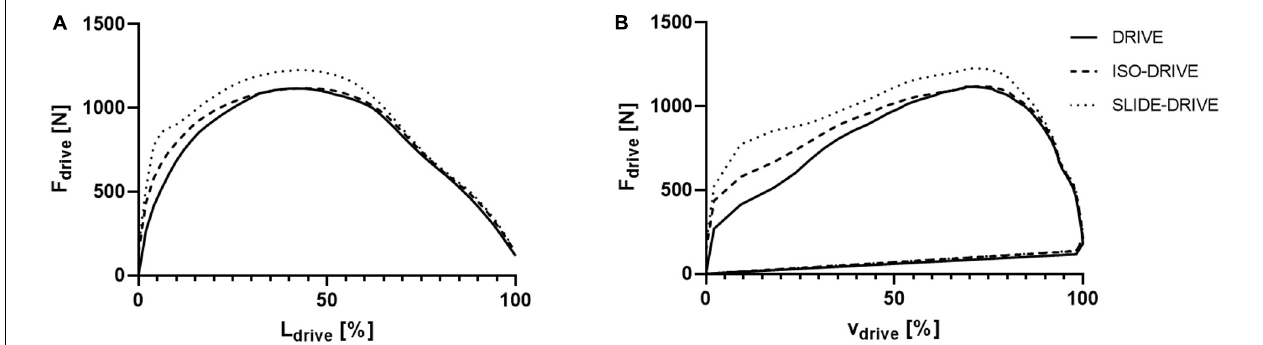
FIGURE 2 | Representation of the average handle force (F drive ) as a function of handle pathway length (length of drive: L drive ; A ) and as a function of handle speed during drive (v drive ; B ) for the concentric (DRIVE), isometric precontraction (ISO-DRIVE), and FEC type (SLIDE-DRIVE) rowing trials. The force length and force–speed graph are normalized to the length of the drive.